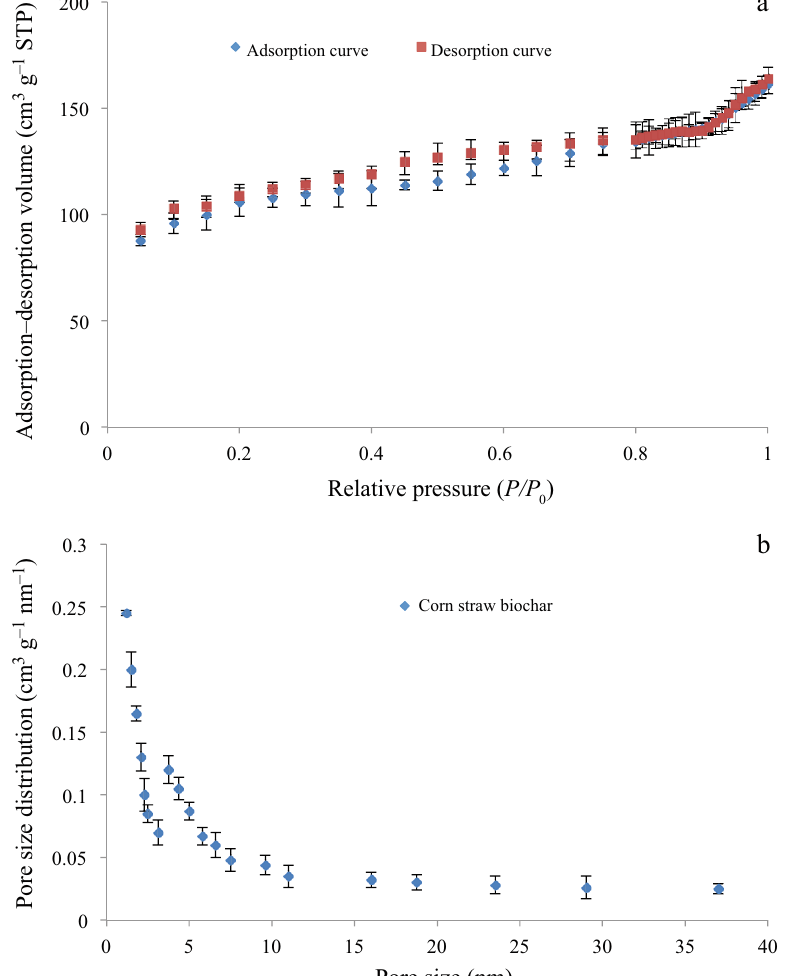
Fig. 2. (a) N 2 adsorption−desorption isotherms at standard temperature and pressure (STP) and (b) relative pore size distribution of maize straw biochar. Error bars: